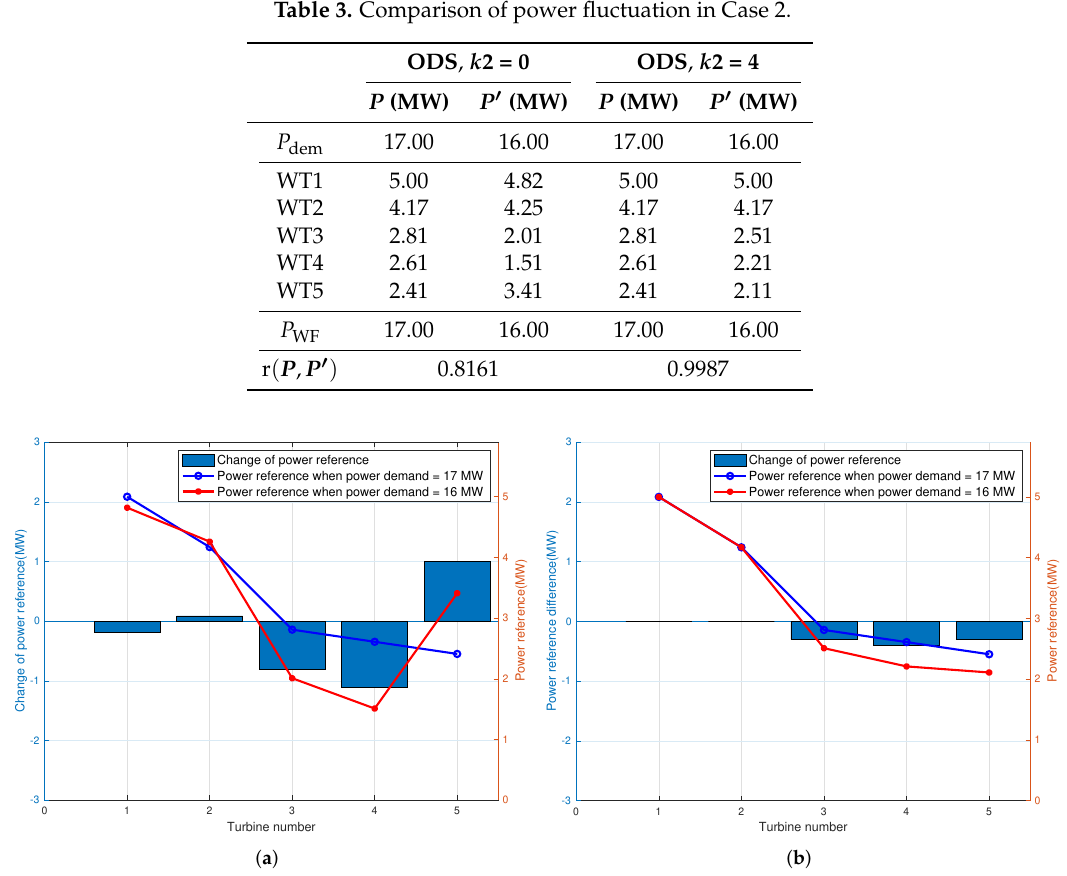
Figure 12. Comparison of power fluctuation in Case 2: ( a ) power references in ODS ( k 2 = 0); ( b ) power references in ODS ( k 2 =